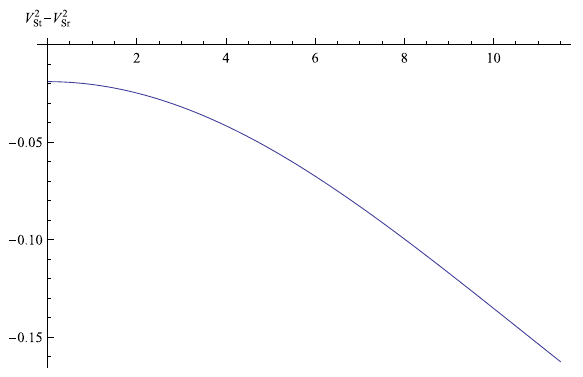
Fig. 5 The square of radial speed of light